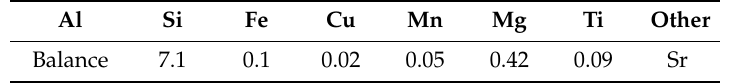
Table 1. Measured chemical composition of the AlSi7Mg0.3 in mass % used in the experiments. Al